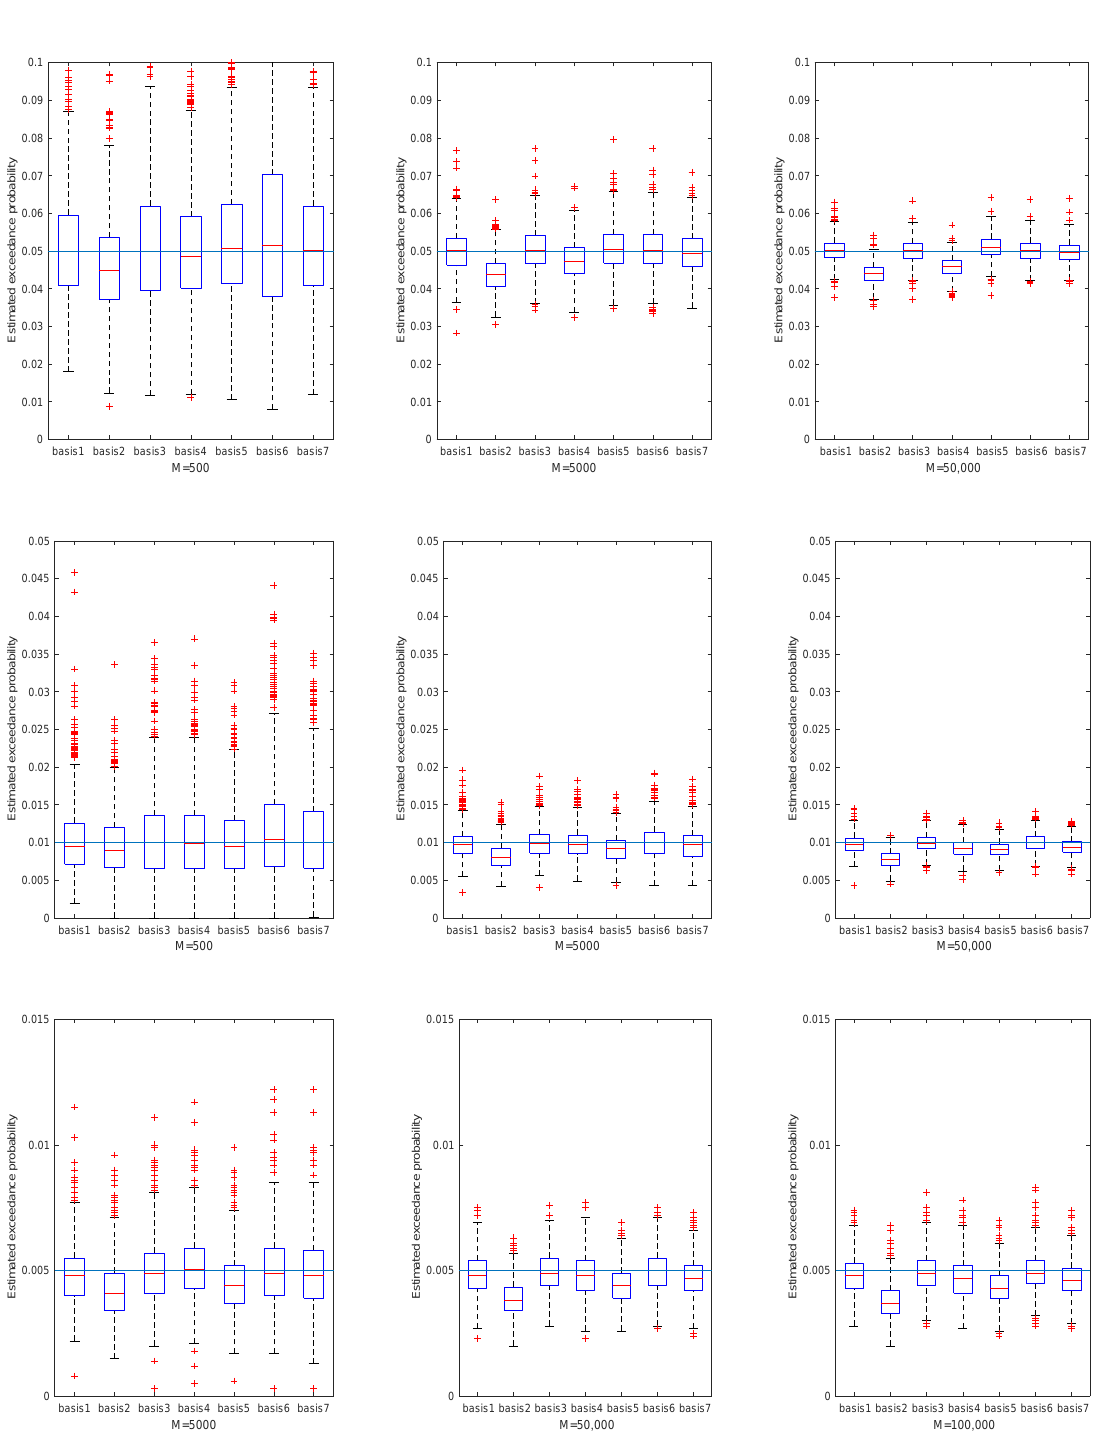
Figure 3. The estimated exceedance probability given the estimated VaR in portfolio 2. Set α = 0.95, 0.99 and 0.995. The three subfigures in the first row correspond to α = 0.95, the three subfigures in the second row correspond to α = 0.99, and the three subfigures in the third row correspond to α =